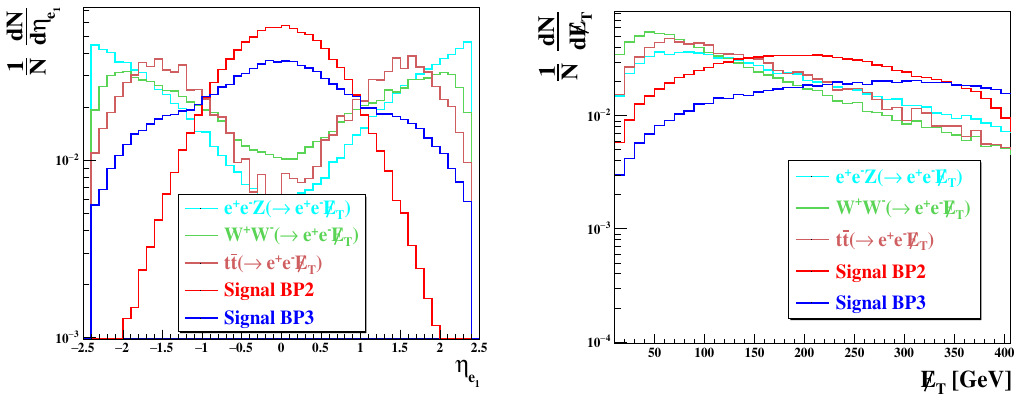
Figure 14 . Variation of fraction of events for backgrounds and signal with respect to transverse missing energy and invariant mass of the di-electron in the left and right panels